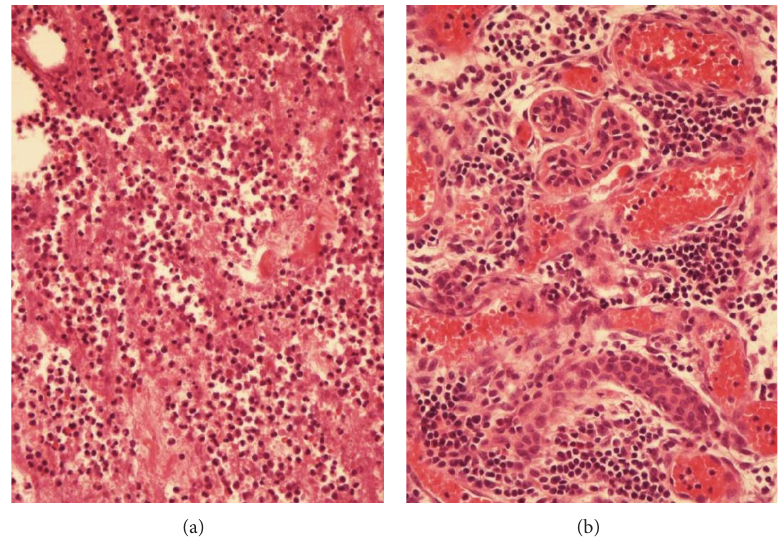
Figure 6: Photomicrograph of the histology: breast tissue was almost completely substituted by necrotic tissue surrounded by heavy polymorph nucleates infiltrate extending from the skin to the adipose tissue. Only few islands of breast tissue were observed (a and